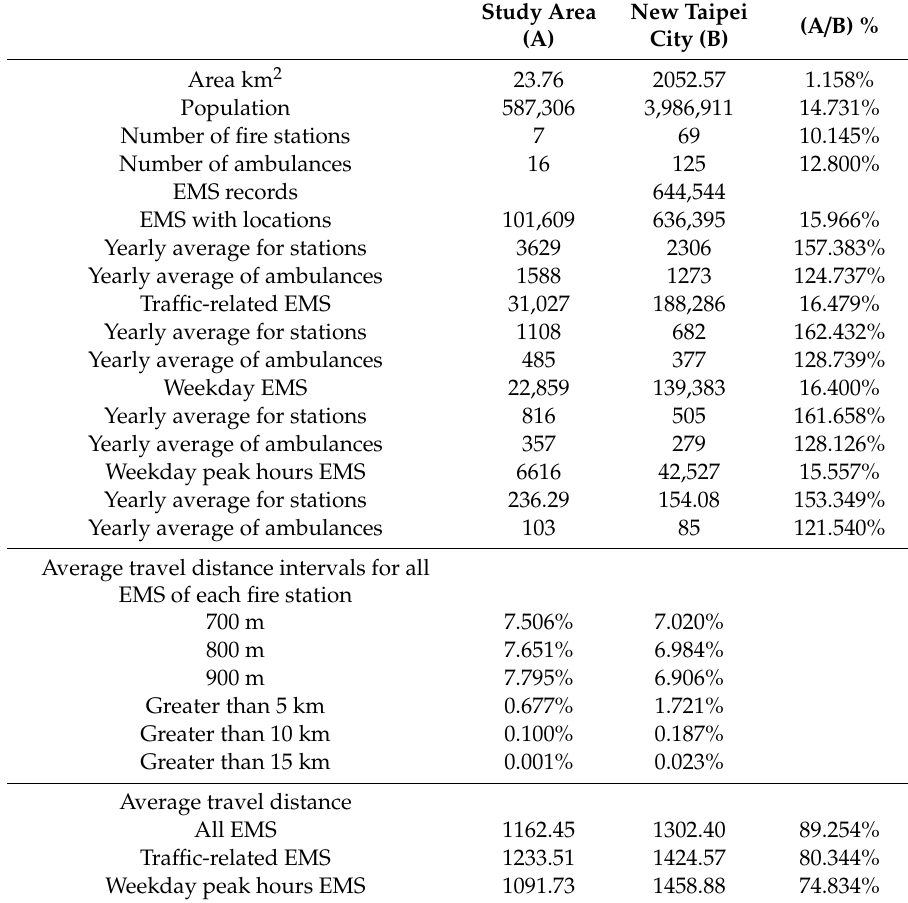
Table 1. Study area descriptions (unit: number of